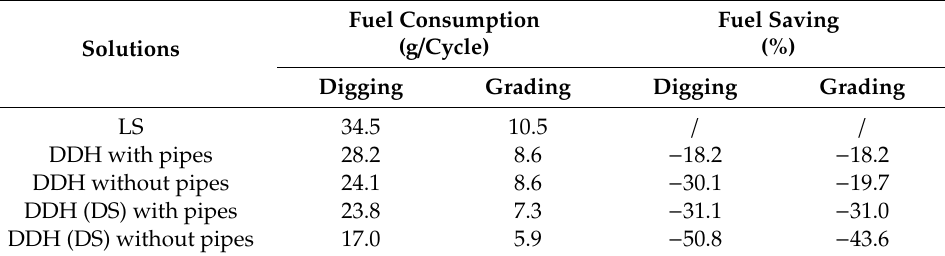
Table 4. Diesel engine fuel consumption.